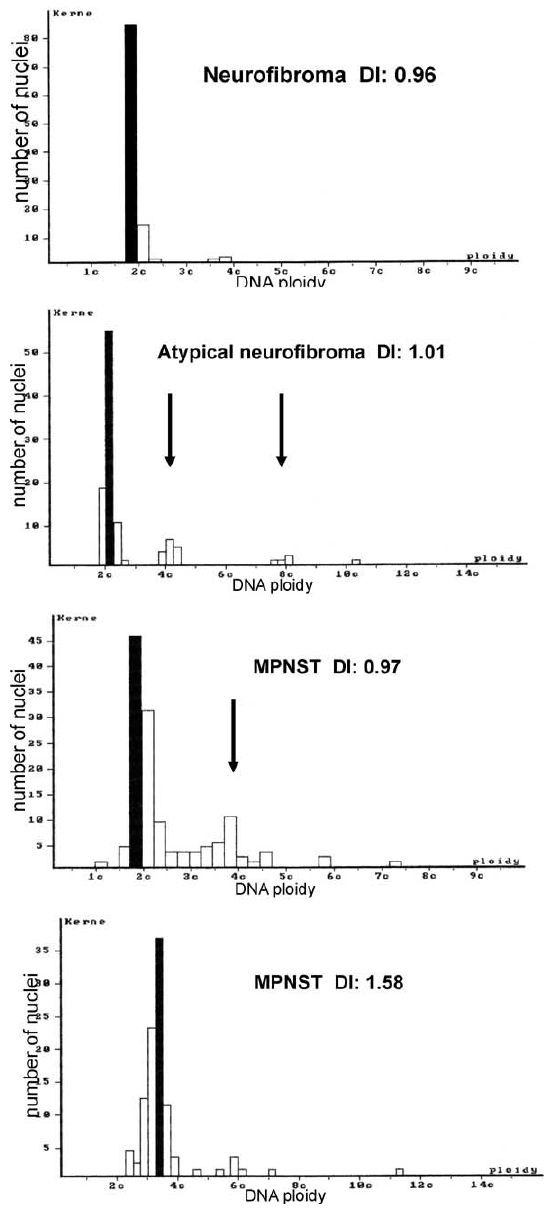
Fig. 3. Histograms of neurofibroma, atypical neurofibroma and two MPNSTs. There is no euploid polyploidisation except atypical neu- rofibroma. 4c peak height value was higher than 10% only in one MPNST (case number 55) but the cells here are G2 phase cells and not true tetraploid cells (see explanation in text). Case numbers: 30, 36, 44,